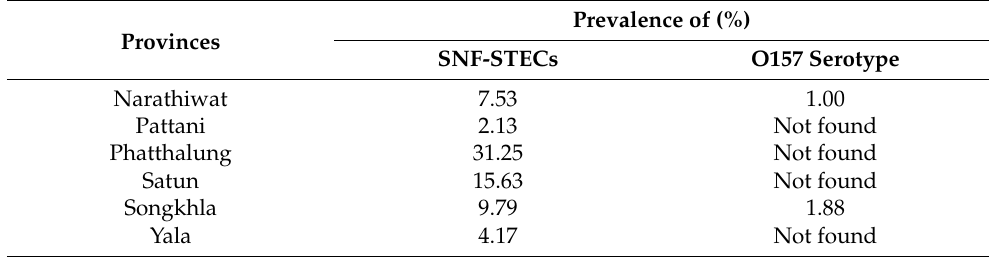
Table 2. Prevalence of SNF-STECs and the O157 serotype in goats according to province.